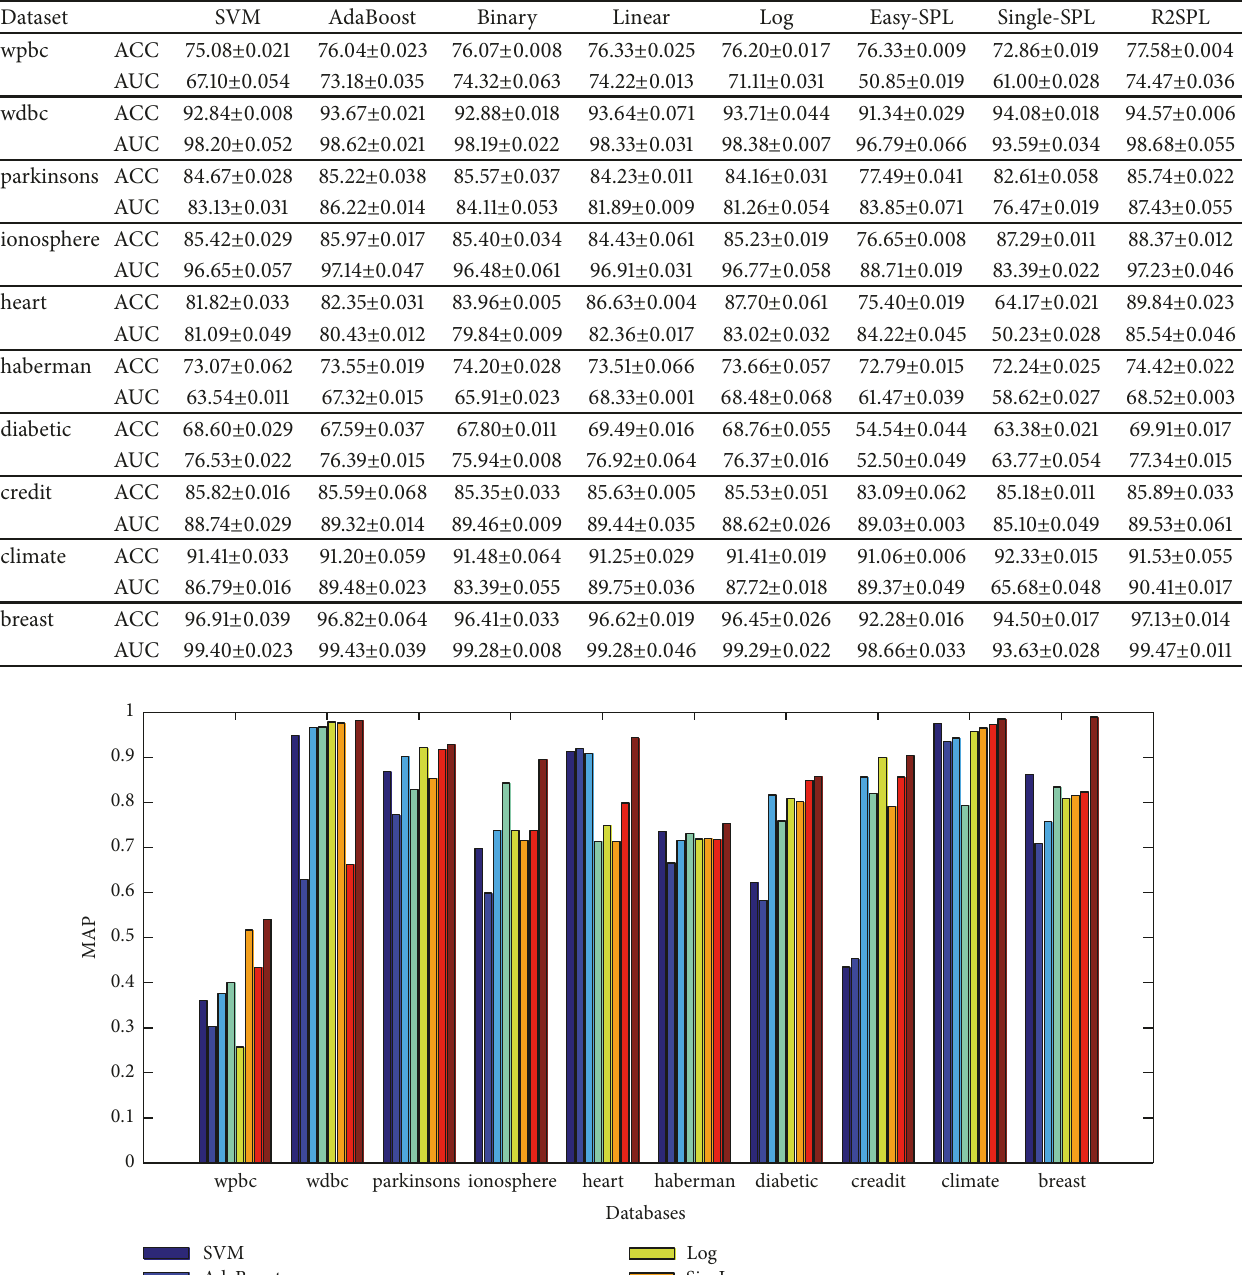
Table 2: Results of seven baselines and our model on 10 UCI datasets.